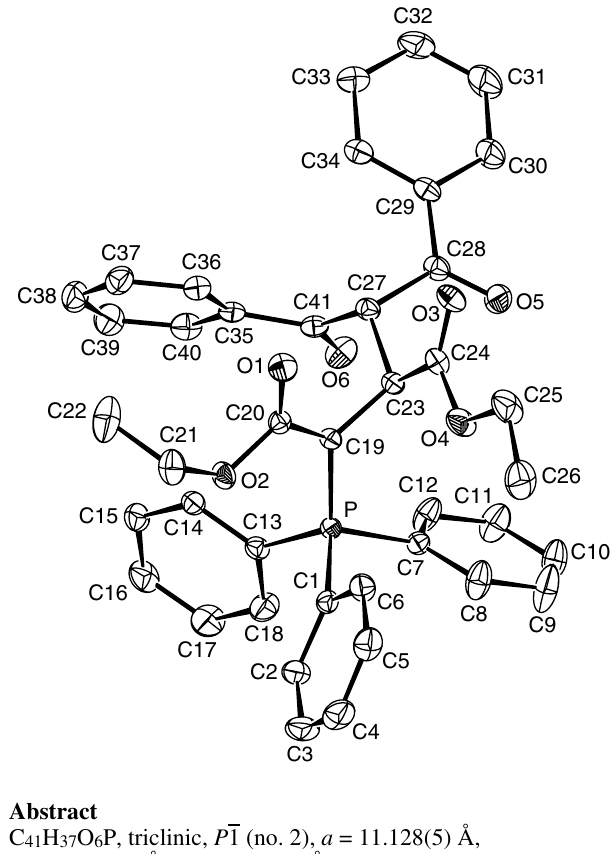
Table 1. Data collection and